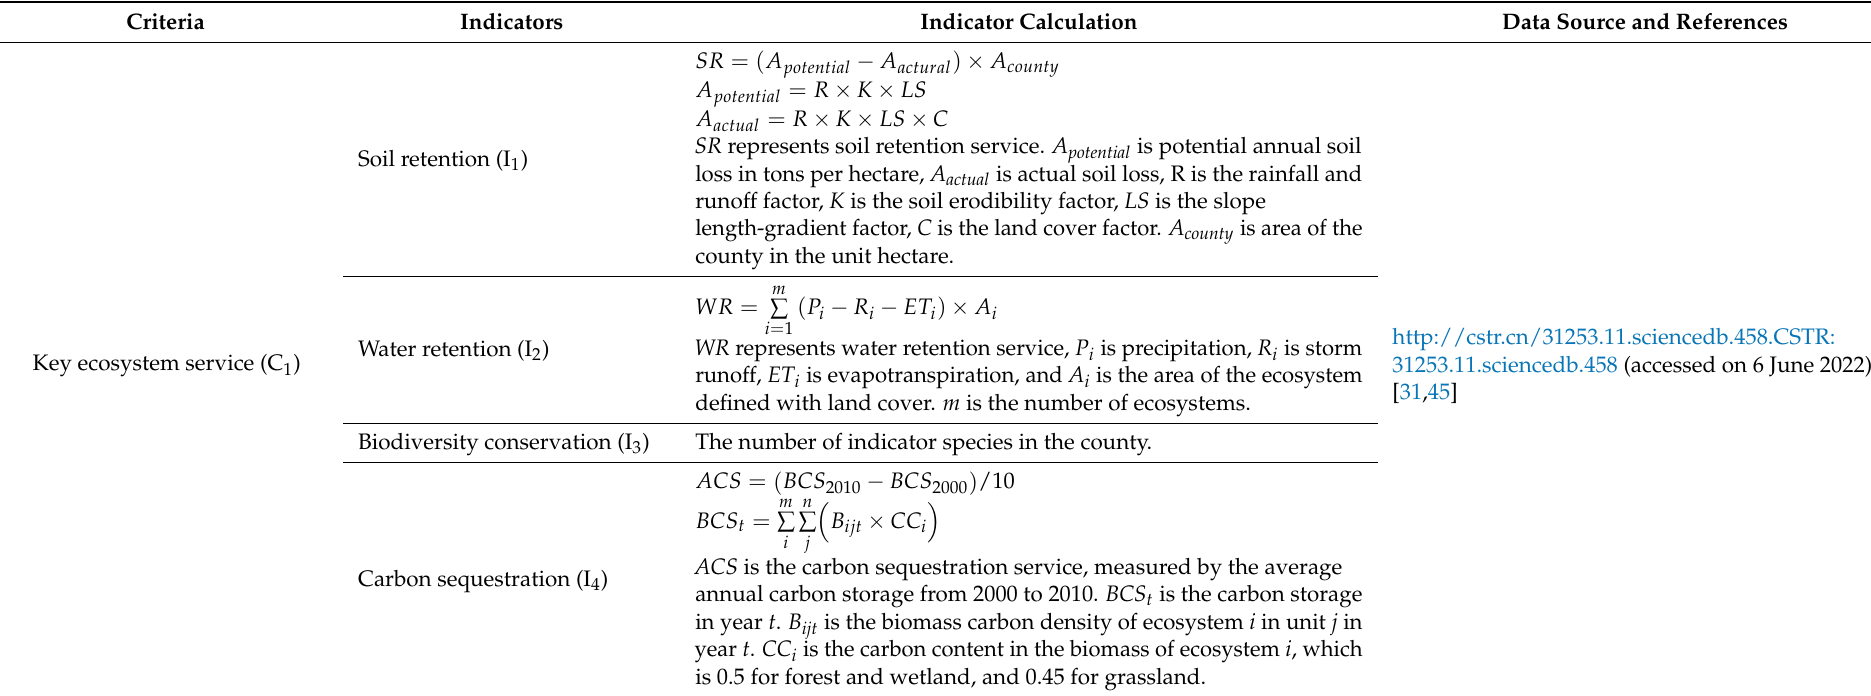
Table 1. Criteria and indicators for evaluating ecosystem service supply